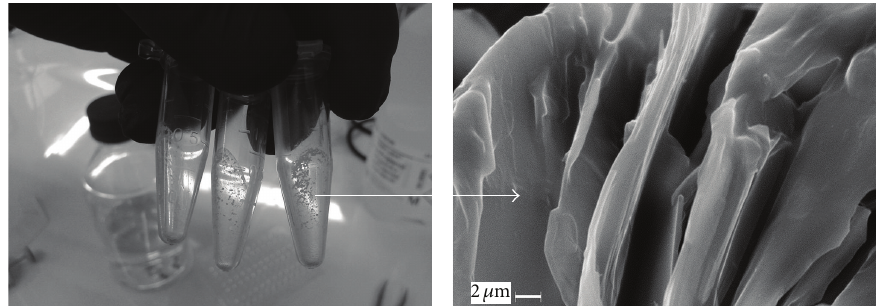
Figure 5: SEM morphology of crystalline amyloid protein on the PET coating surface.